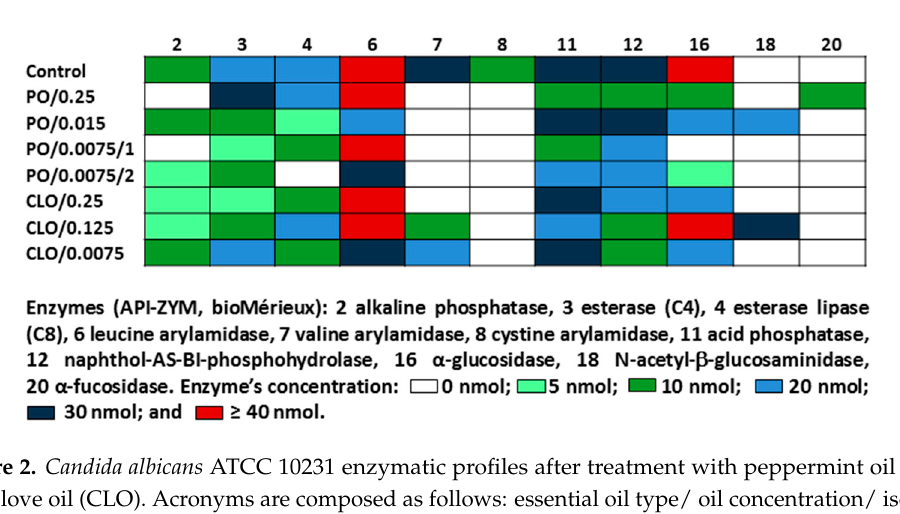
Figure 2. Candida albicans ATCC 10231 enzymatic profiles after treatment with peppermint oil (PO) and clove oil (CLO). Acronyms are composed as follows: essential oil type/ oil concentration/ isolate number (if any).